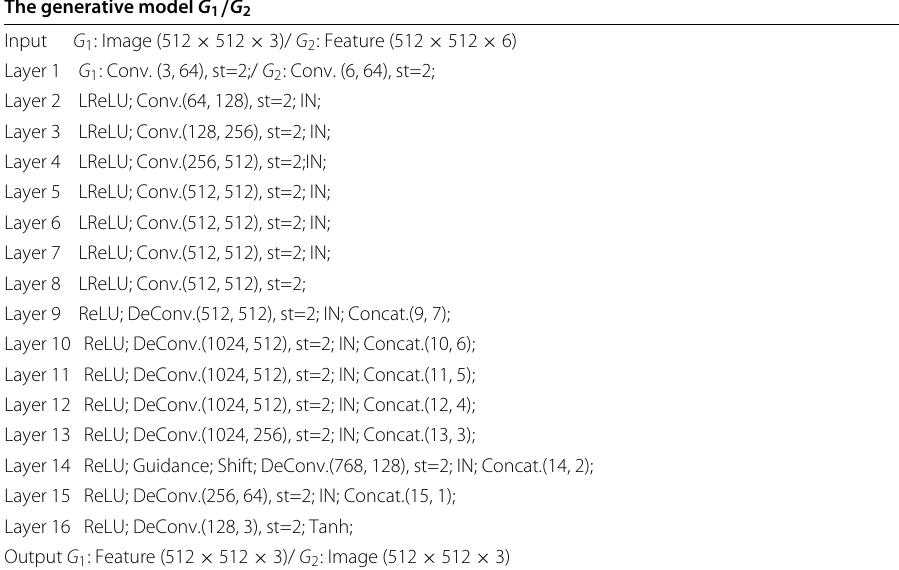
Table 1 The architecture of G 1 / G 2 network. “IN” represents InstanceNorm, “LReLU” represents Leaky ReLU activation, “Conv.”/“DeConv.” denotes convolutional/transposed convolutional layer with kernel size of 4, “st” means stride, “Concat” explains the skip connections, “Guidance” means guidance loss operation, and “Shift” means shift-connection operation. The different layers of G 1 and G 2 are listed